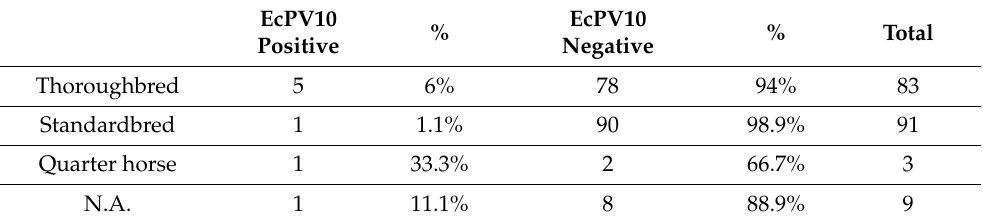
Table 3. EcPV10 genoprevalence detected in different